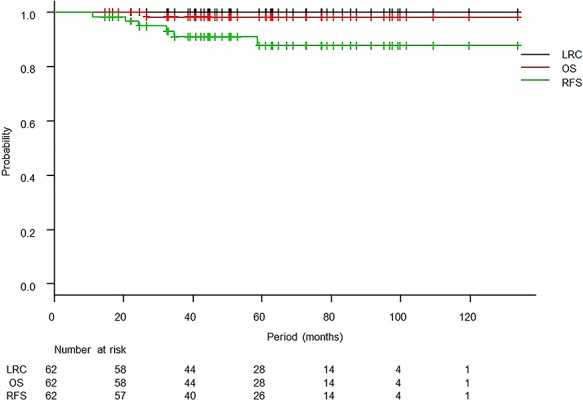
Kaplan–Meier curves of locoregional control (LRC), overall survival (OS) and relapse-free survival (RFS).